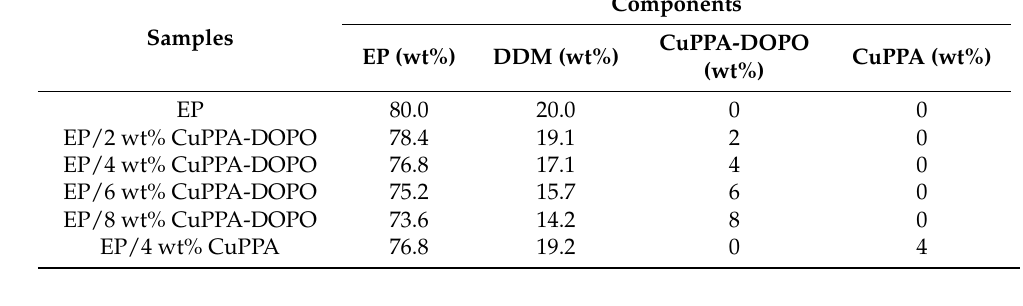
Figure 8. Synthetic route of (a) amino phenyl copper phosphate; (b) DOPO-amino phenyl copper phosphate.